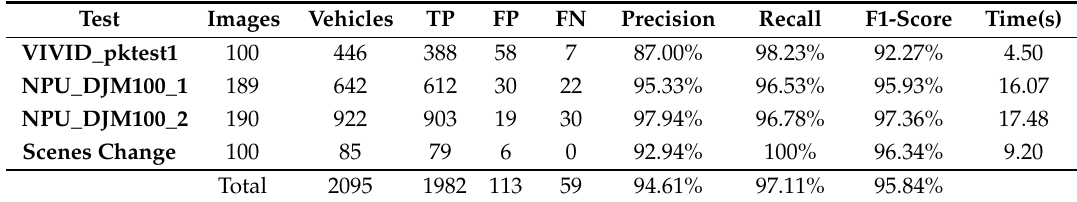
Table 4. The performances on the test images. FP: false positive; TP: true positive; FN: false